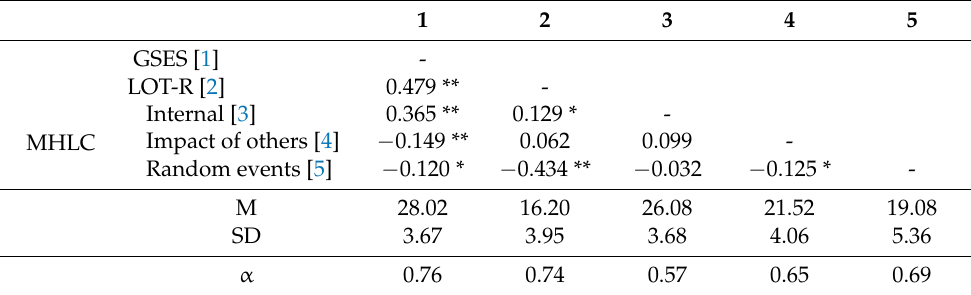
Table 2. Descriptive statistics and correlations between the analyzed variables.